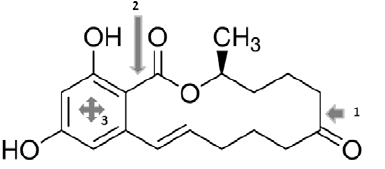
Figure 6. Putative mechanisms of the ZEA biodegradation by Rhodococcuspyridinivorans K408. The arising metabolites and the zearalenone degradation mechanism of Rhodococcus pyridinivorans K408 are unknown yet. However, previous studies suggest various ways how zearalenone could be degraded by microbes. Trichosporon mycotoxinivorans ( 1 ) and Clonostachys rosea IFO 7063 ( 2 ) are able to open the lactone ring resulting non-estrogenic metabolites which are 1- (3,5-dihydroxyphenyl)-10 9 -hydroxy-1-undecen-6 9 -one and (5S)-5-({2,4- dihydroxy-6-[(1E)-5-hydroxypent-1-en-1-yl]benzoyl}oxy) hexanoic acid, respectively. In addition, Rhodococcus pyridinivorans K408 have versatile metabolic pathways and the most of them are able to degrade aromatic compounds. It suggests that opening the aromatic ring is also a possible way to degrade zearalenone ( 3 ).